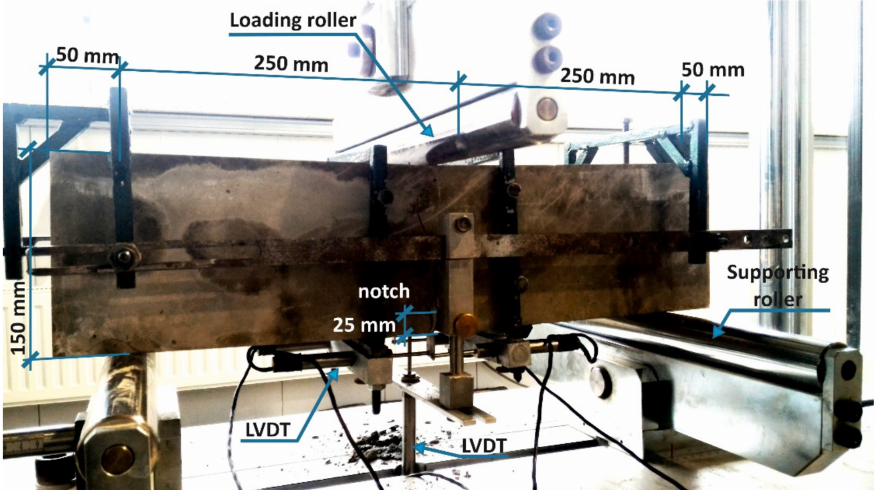
Figure 4. Geometry and static scheme of tested beams with the displacement sensors system for measuring the deflection and crack width (CMOD).